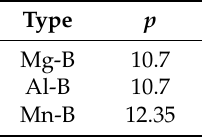
Table 5. The value of the parameter p in Miedema model.